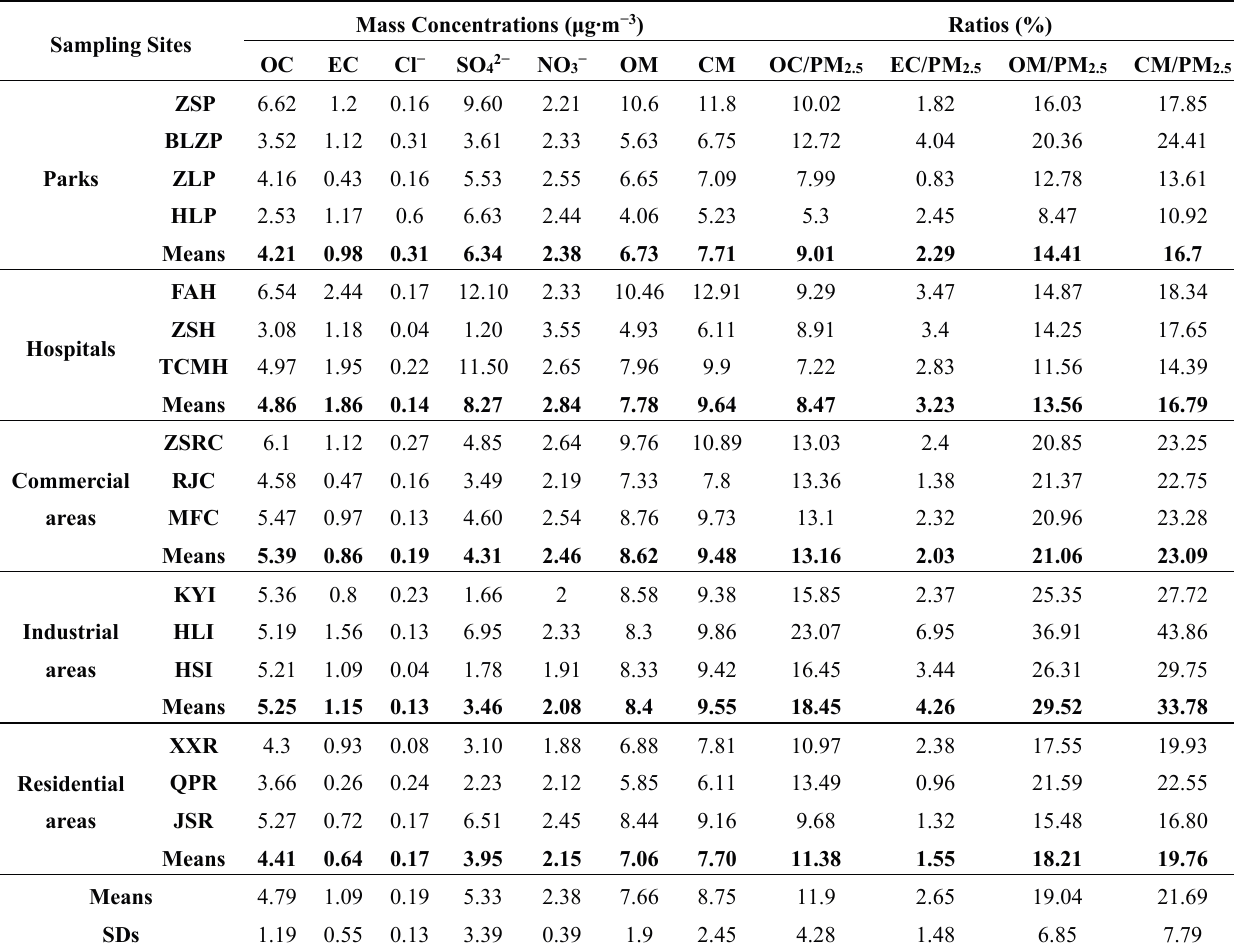
Table 4. Mass concentrations of OC, EC, and anions during the sampling period at different sites in